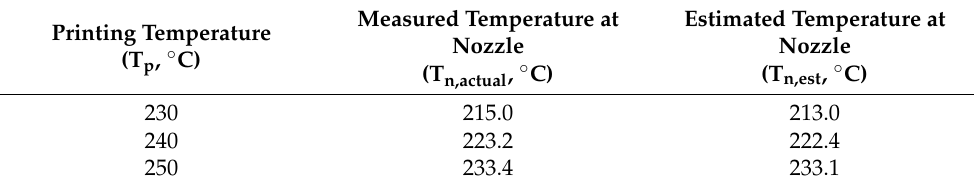
Figure 8. Temperature distribution at extruder unit for different printing temperatures: ( a ) T p = 230 °C; ( b ) T p = 240 °C; ( c ) T p = 250 °C. Table 6. Comparison of measured temperatures and estimated temperatures at the nozzle for different printing temperatures.